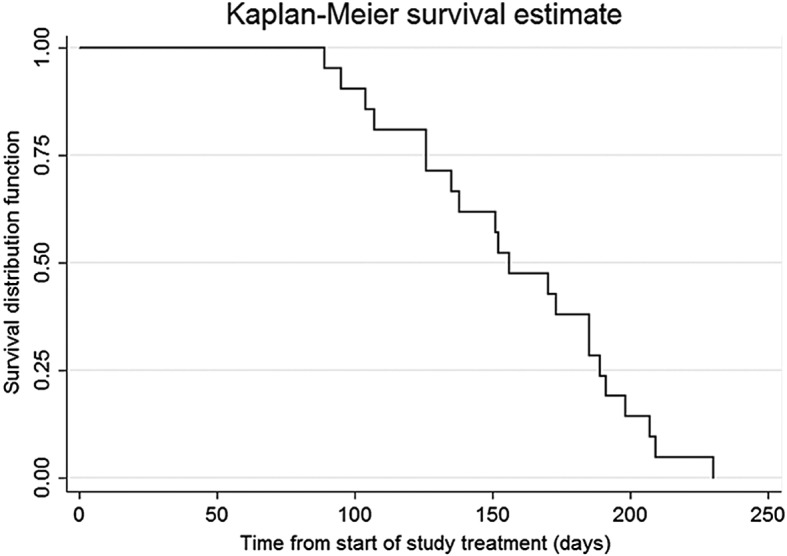
Kaplan-Meier estimate of the median time to progression was 5.2 months (95% confidence interval, 4.2–6.2 months).